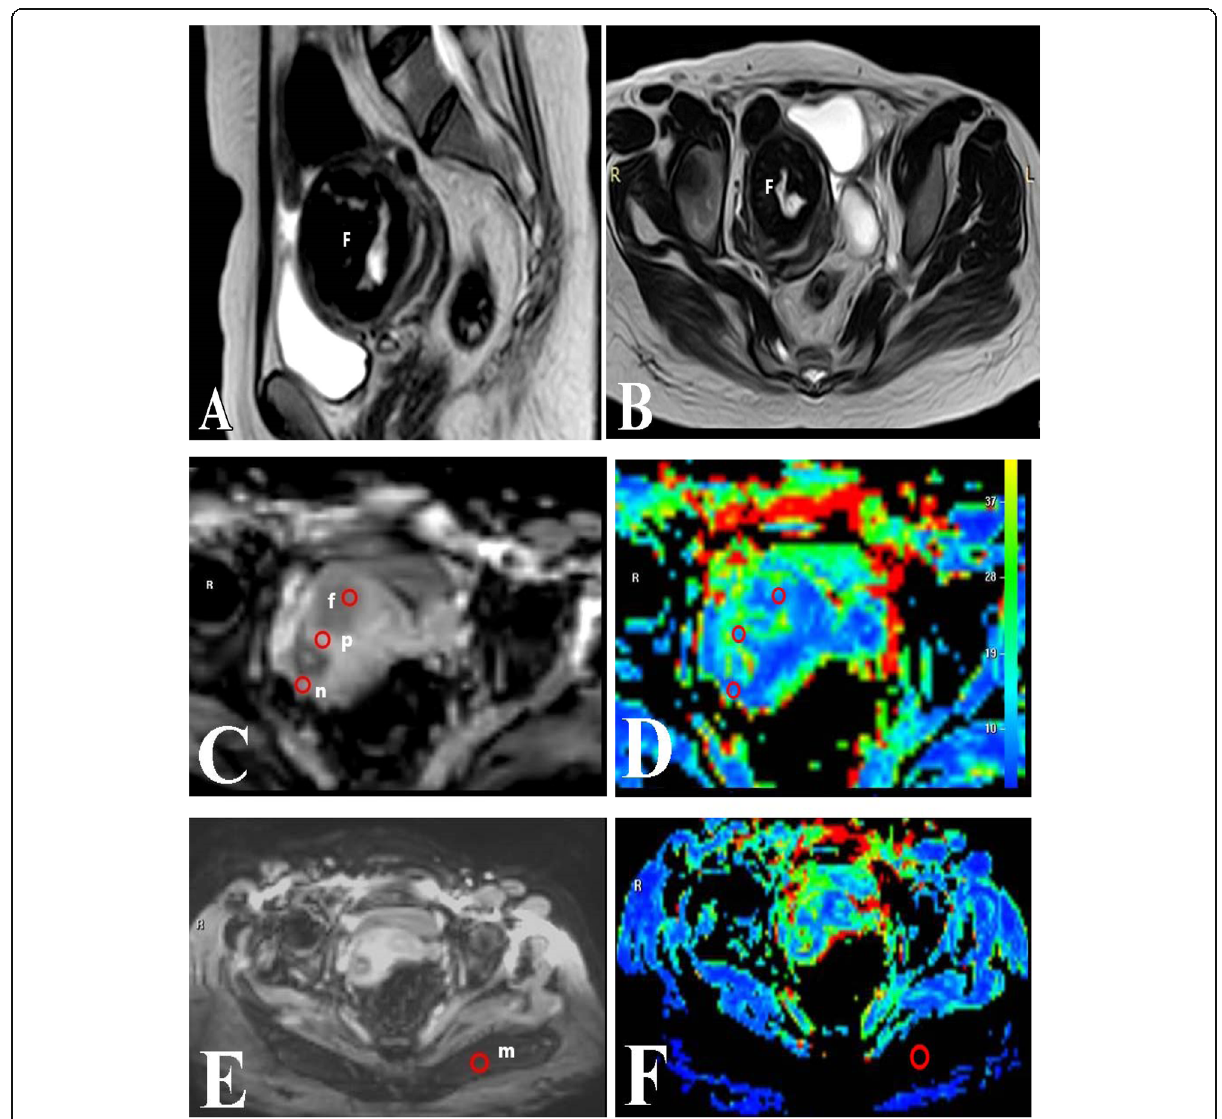
Fig. 4 Infertile female patient aged 41 years old. a , b Sagittal and axial T2WI of the uterus showing anterior wall submucous fibroid [F] with low T2 SI and central areas of high T2 SI due to central necrosis measuring 6 × 5 × 5.5 cm (ApxTrxHt). c , d ASL gray scale map and ASL color map with the ROIs put at the anterior wall (positive wall; p), posterior wall (negative wall: n), and in the fibroid (f). e , f ASL gray scale map and color map with the ROI put at the gluteus muscle (m). In this case, the perfusion of the positive wall was 725, the negative wall was 862 while in the fibroid was 670 denoting that the perfusion was lower in the positive wall than the negative wall while the perfusion of the fibroid was less than both positive and negative uterine walls